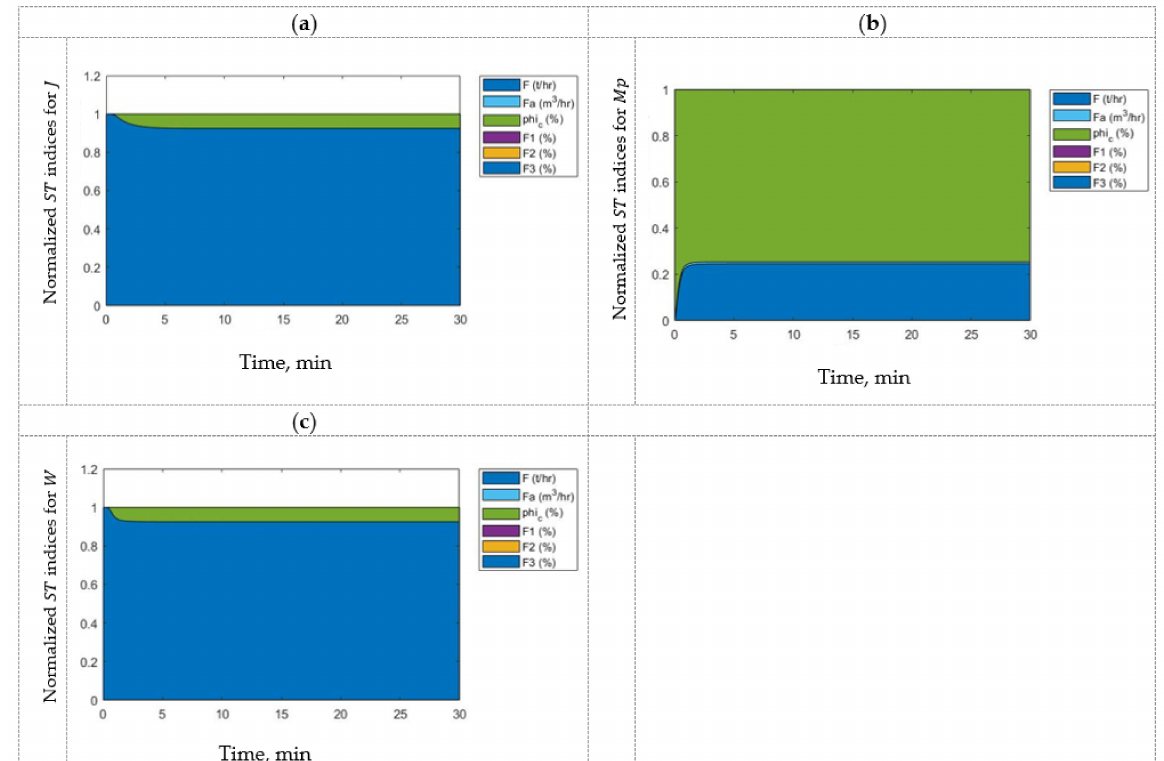
Figure 3. ( a ) SAG mill as MIMO system, and UA results using ( b ) mill filling, ( c ) power consumption, and ( d ) mass retained as output variables.